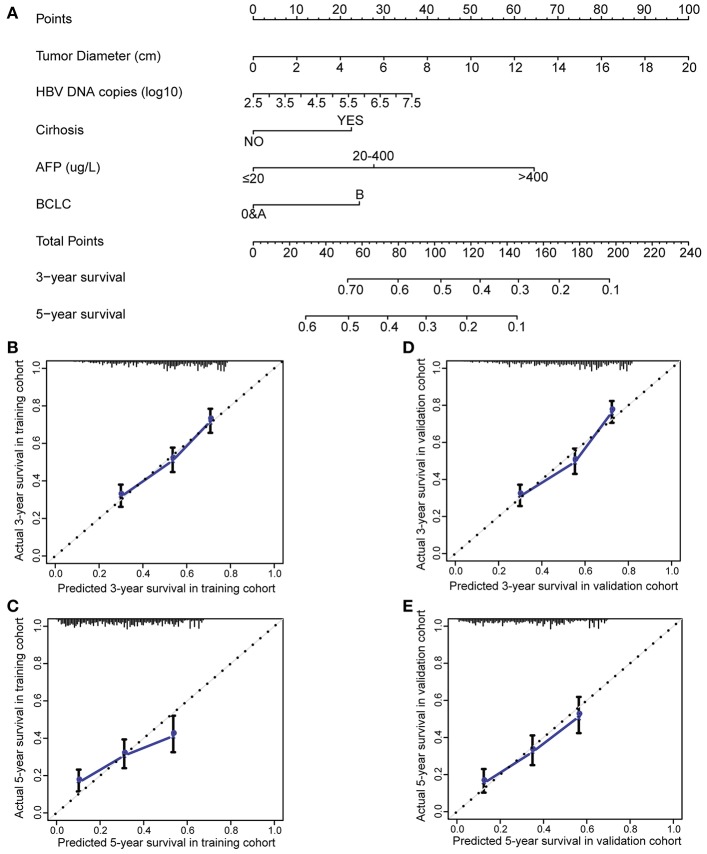
Preoperative nomogram and the calibration curve for predicting postoperative survival of patients with HCC. (A) The nomogram. To use this nomogram, a patient's value is located on each variable axis, and a line represents the number of points received for each variable value. The sum of these numbers is located on “Total Points” axis, and a line is drawn downward to the survival axes to determine the likelihood of postoperative 3- or 5-year survival. (B) The calibration curve for predicting postoperative 3-year survival in the training cohort. (C) The calibration curve for predicting postoperative 5-year survival in the training cohort. (D) The calibration curve for predicting postoperative 3-year survival in the validation cohort. (E) The calibration curve for predicting postoperative 5-year survival in the validation cohort. AFP, alpha-fetoprotein; BCLC, Barcelona Clinic Liver Cancer; HCC, hepatocellular carcinoma.